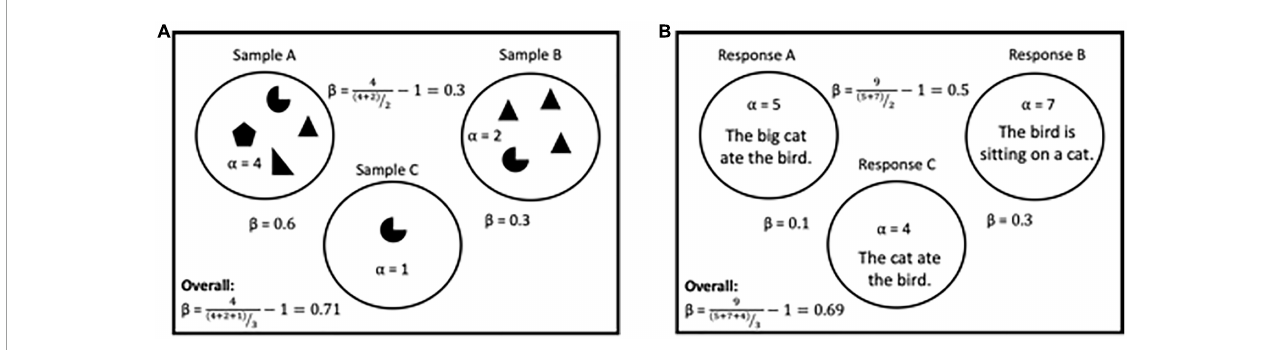
FIGURE1 Schematics of ecological diversity terms. (A) For ecological diversity, three samples (open circles) are shown with differing numbers of individuals, representing a different species (filled shapes). Alpha values are given for each sample, and beta values are given for each pairing and the overall data set. Example calculations are provided for beta between Sample A and B and the data set overall. (B) For language applications, responses are compared instead of samples, while words are treated as individuals. Repeated words are equivalent to being the same species. While only single sentences are shown here, our data set contains many CRs that contain more than one sentence that are still treated as single samples. Alpha values are given for each response, and beta values are given for each pairing and the overall data set. Example calculations are provided for beta between response A and B and the data set overall.